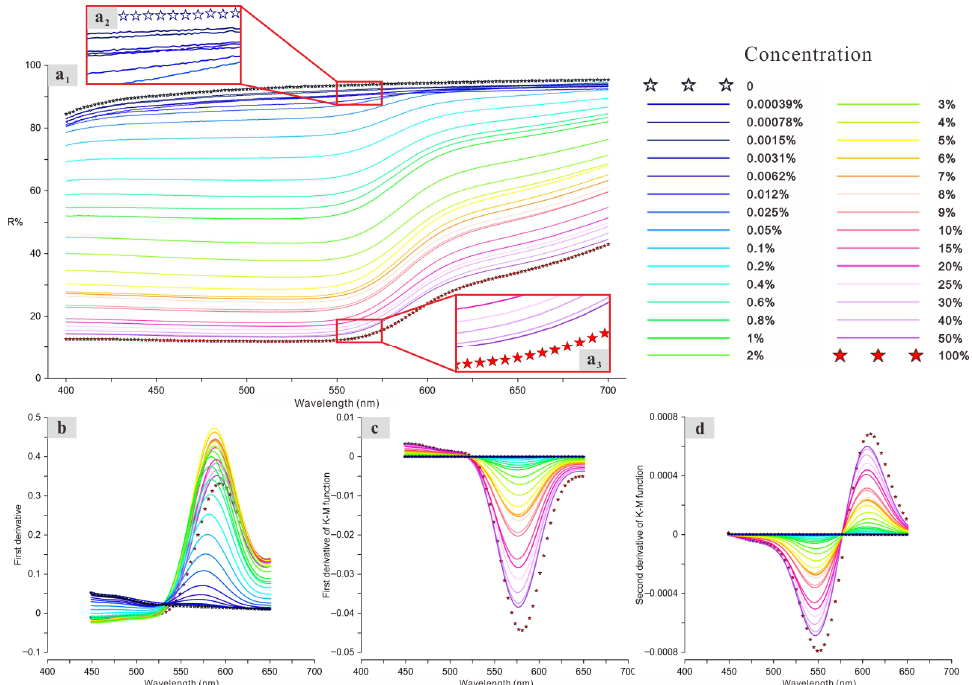
Figure 3. Reflectance spectra and processing results of manufactured samples with various hematite concentrations. ( a 1 ) The raw reflectance response. Local amplified reflectance curves of manufactured samples at low ( a 2 ) and high ( a 3 ) concentrations. The first derivative of raw reflectance curves ( b ), the first ( c ) and second ( d ) derivatives of the K–M function.